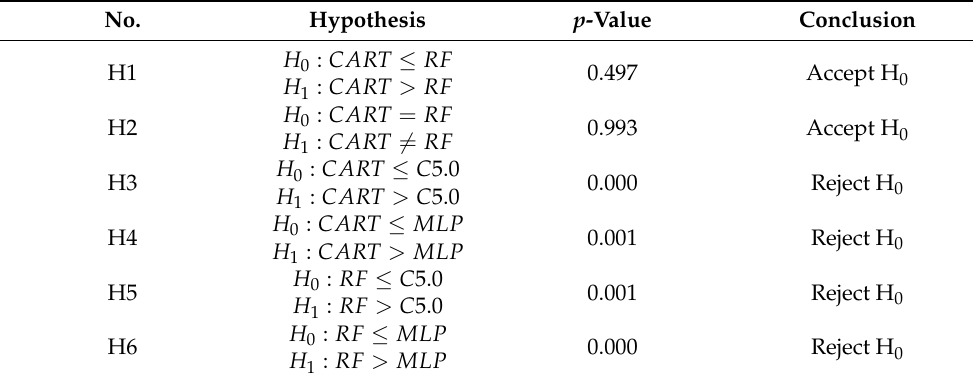
Table 7. Results of statistical hypotheses for comparison.